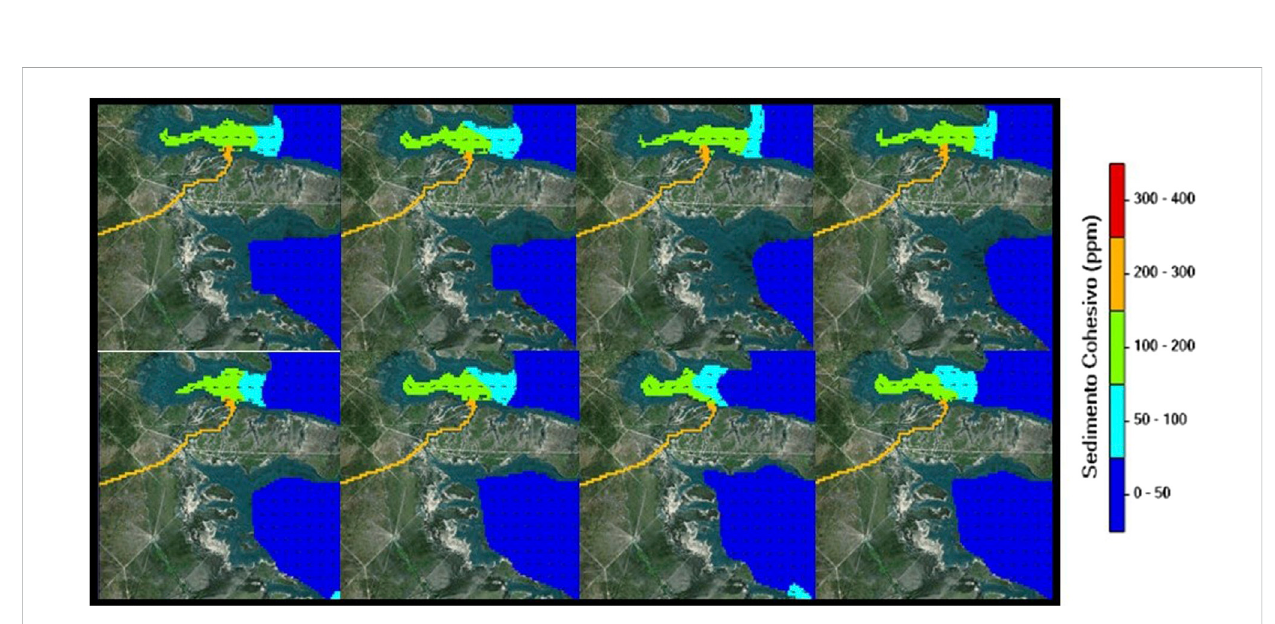
CS discharges of Irrigation network over the sea- 2019/01/03 (00 – 21